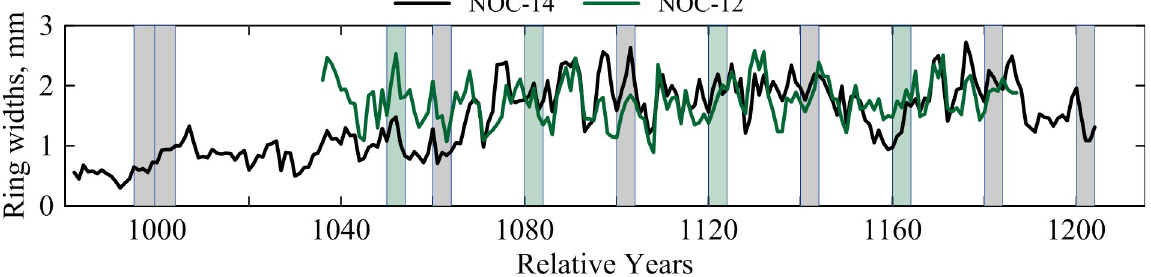
Fig 14. The tree-ring width patterns for the NOC-12 and 14 samples showing where the segments of NOC-12 (green bars) and NOC-14 (gray bars) were taken for 14 C dating.